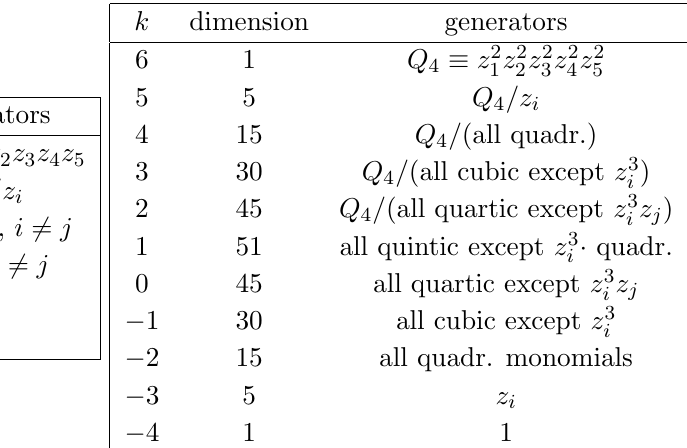
6 ; T ( k )) for all the k for which it is non-zero. Left,